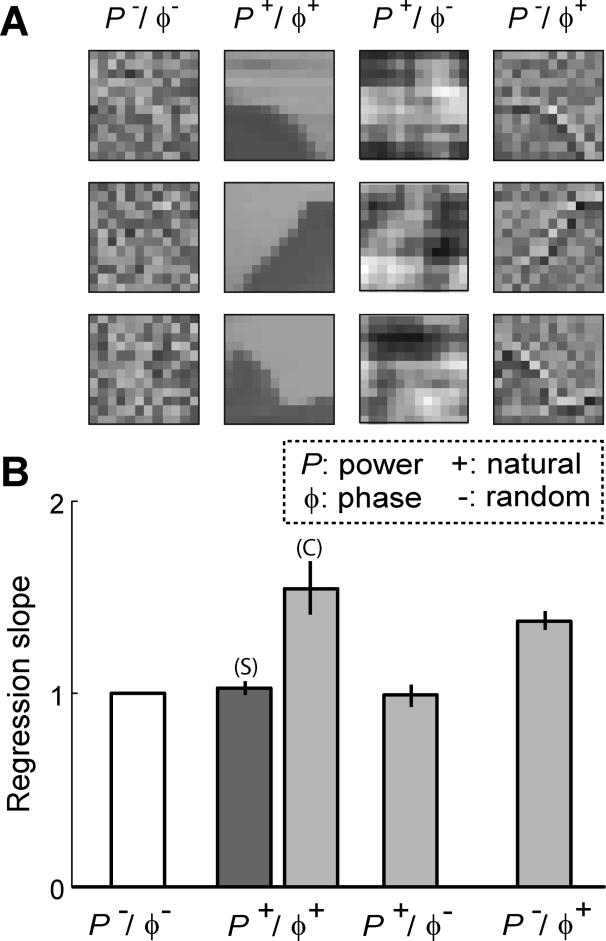
Effects of Power and Phase Spectra of Stimuli on Cortical Feature Sensitivity(A) Four classes of stimulus ensembles with distinct combinations of power (P) and phase (φ) characteristics; +: natural; −: random. Example stimuli from each class are shown. The P−/φ− and P−/φ+ stimuli are matched for both the global contrast and the feature contrasts for a particular complex cell.(B) Summary of cortical feature sensitivity (contrast-response gain; see Figure 3B) for the stimulus classes in (A). In each experiment, a random (P−/φ−) stimulus ensemble was generated to match P
+/φ+, P
+/φ−, or P−/φ+ in global and feature contrasts (see Figure 2 and Materials and Methods), and the measured contrast-response gain was plotted against the gain for P−/φ− (as in Figure 3B). Bar represents slope of linear regression (through origin); >1 indicates higher contrast-response gain relative to P−/φ−. Error bar: ± standard deviation. P
+/φ+ bars for simple (S) and complex (C) cells were computed from data in Figures 3B and 4B, respectively, and P
+/φ− (n = 10, from six cells) and P−/φ+ (n = 11, from six cells) were from largely nonoverlapping populations of complex cells (one cell was used in two separate experiments).